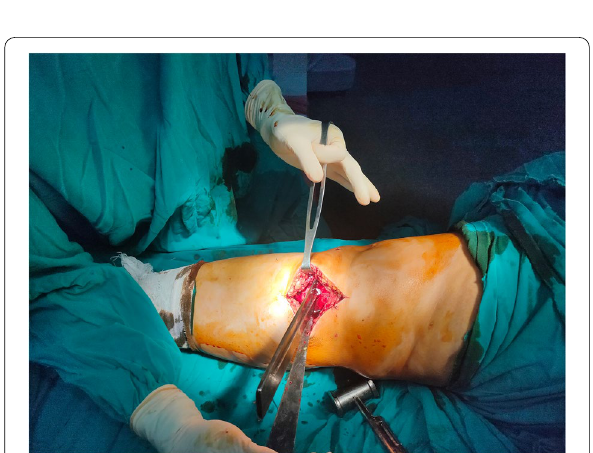
Fig. 8 Open‑wedge high tibial osteotomy after